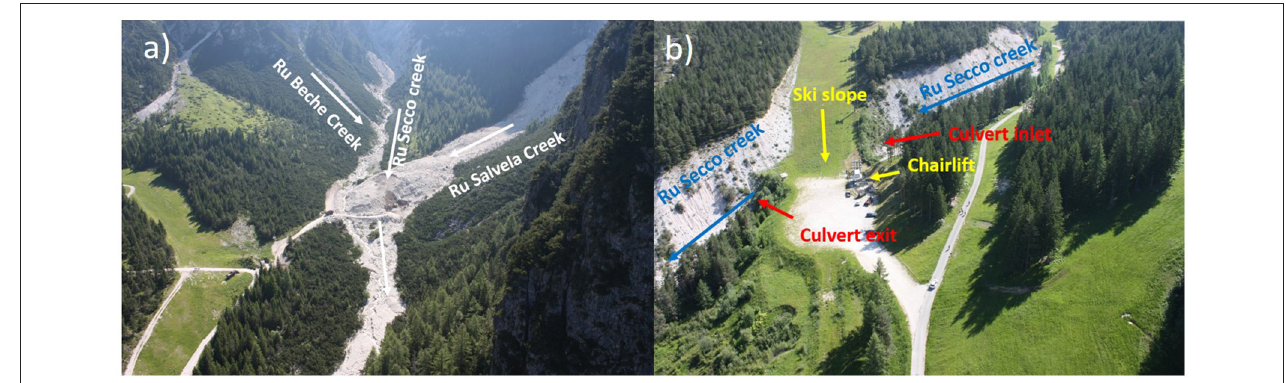
FIGURE 3 | Pre-event images: view of the large debris deposits covering the Ru Salvela and Ru Secco creeks during their removal (flight of 1 July 2015) (a) and the culverting of the Ru Secco in correspondence with the ski resort area (b) .